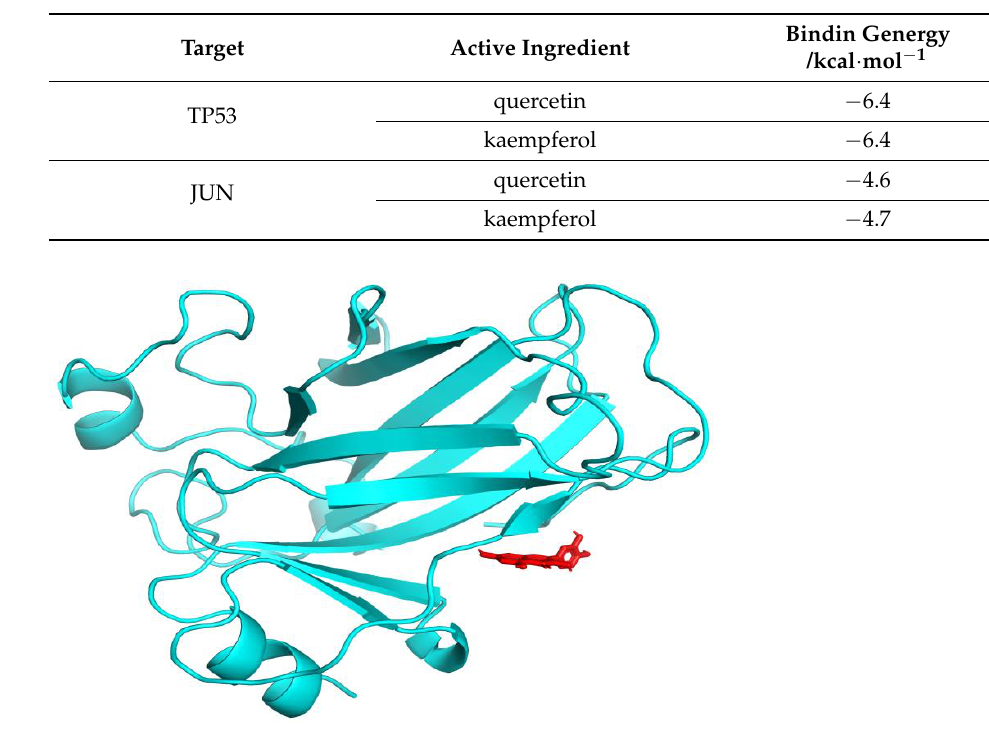
Figure 5. KEGG enrichment analysis diagram. Table 4. Molecular docking information.